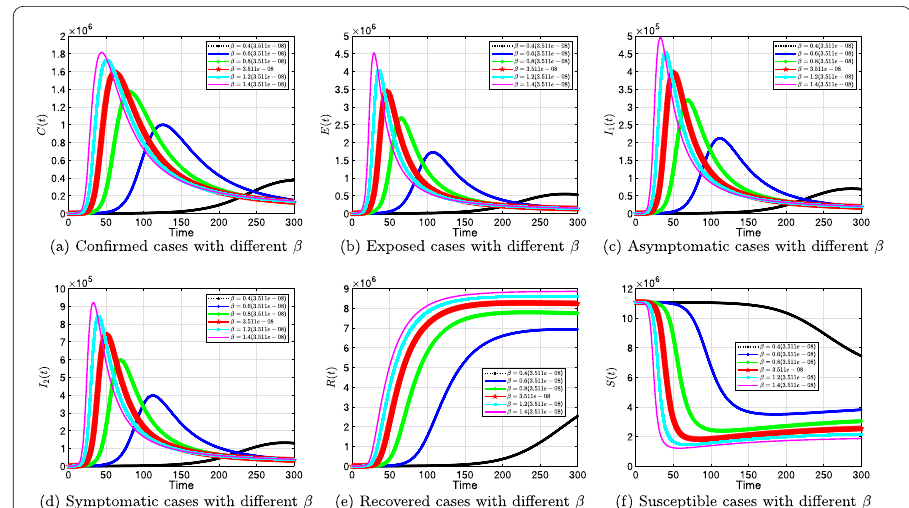
Figure 7 Solution profiles for the COVID-19 model with different β when α = 0.9